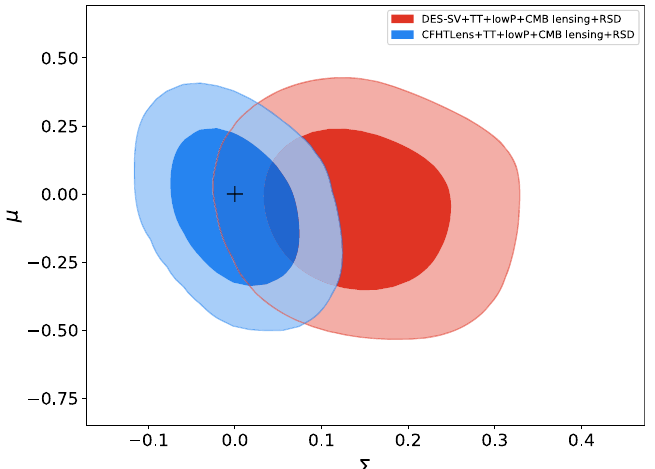
Fig.8 Contour plots for 68% and 95% CL on MG parameters Σ and μ combining Planck CMB data (TT + lowP + CMB lensing), RSD data from BOSS DR12 and 6dFGS, and cosmic shear data from CFHTLenS in blue and DES-SV in red. The cross point represent the GR values (0,0) according to the authors’ definitions and show that GR is consistent with the data sets used. The combination for the contours in blue gives among the tightest current constraints on MG parameters as: Σ = − 0 . 01 % confidence level). Figure reproduced with permission from Ferté et al.